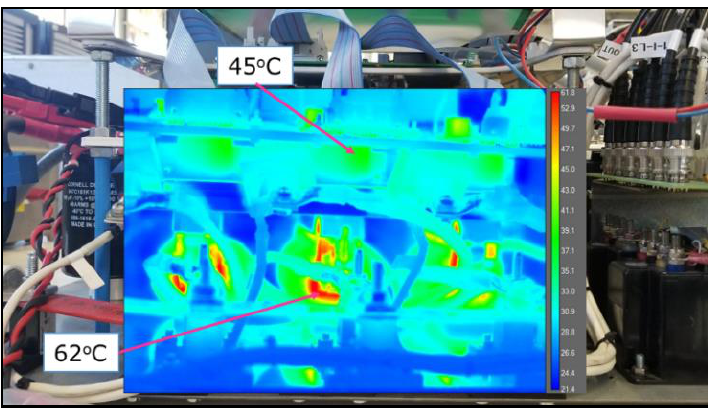
Figure 16. Inductor core temperature (62 °C) and half-bridge module temperature (45 °C) measured from FLIR thermal camera.